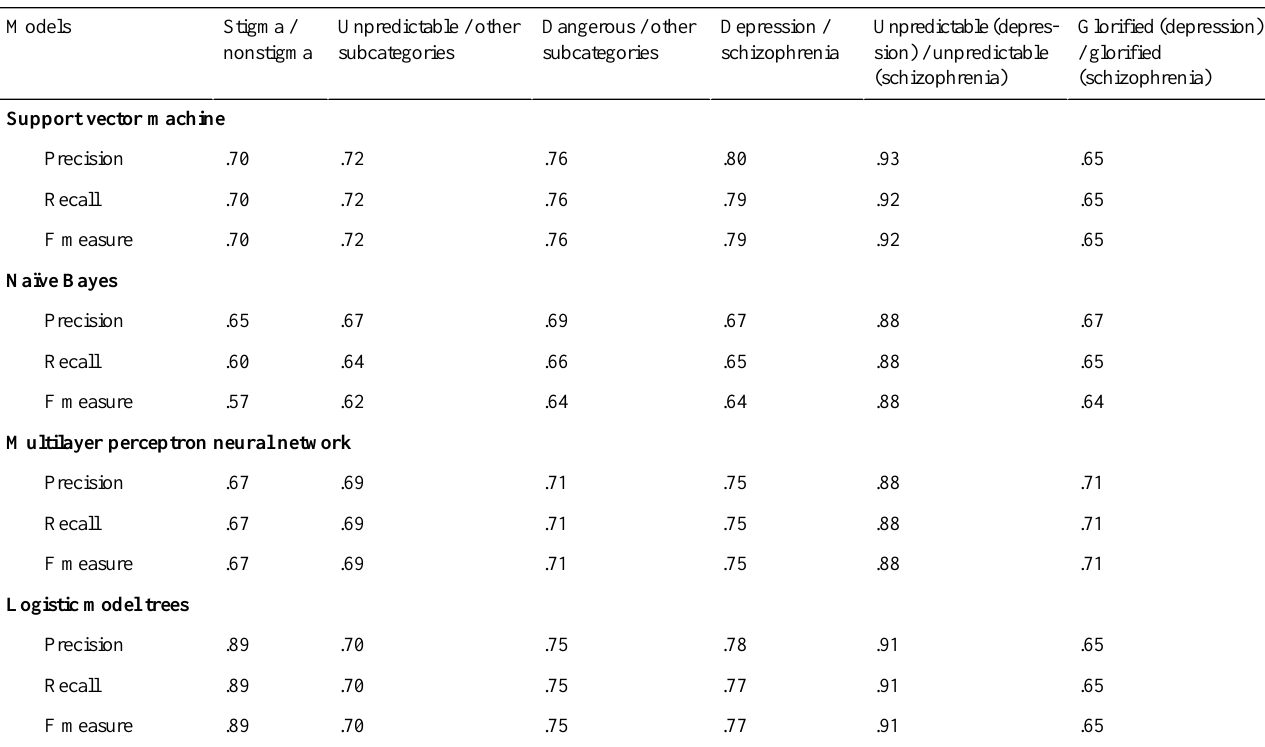
Table 3. Performance of classification